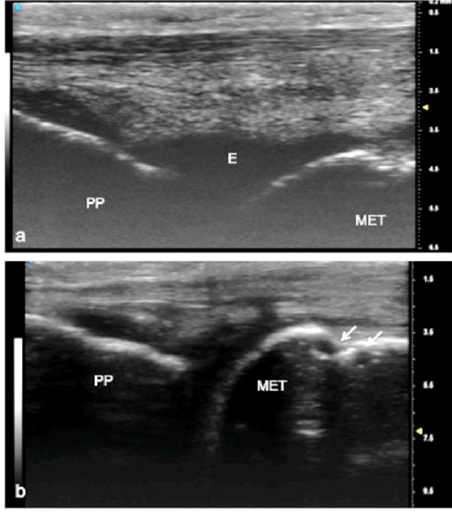
Figure 4. Juvenile idiopathic arthritis (JIA). UHFUS gives clear details of pathological findings in pediatric patients with JIA. In ( a ), articular effusion (E) at the level of the metacarpal–phalangeal joint (MET-PP). In ( b ), osseous erosions at the level of the metacarpal head (white arrows).